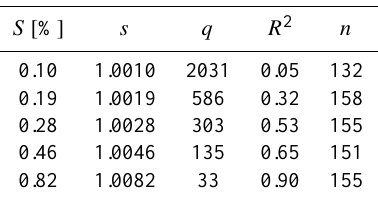
Table 5. Best fit parameters for the modified power law (MPL): N CCN , S = N CN , 30 (s) − q . R 2 is the correlation coefficient, and n is the number of data points.